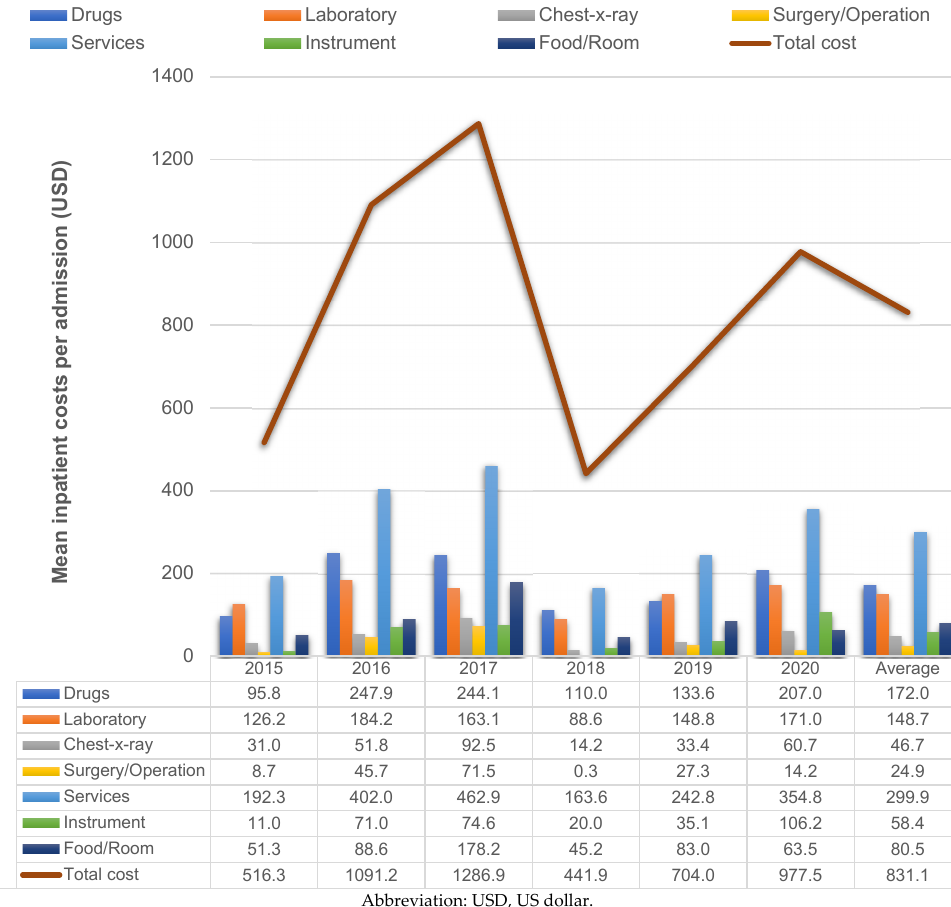
Figure 3. Mean inpatient costs per admission over a 6-year period. According to a multivariable GLM, the length of stay had a signi fi cant impact on the total cost of inpatient visits. It was found that 1 additional day of hospitalization incurred an additional cost of THB 1945 (USD 53.1), as shown in Table 5. Table 3. Total and disaggregated cost items of outpatients and inpatient visits.